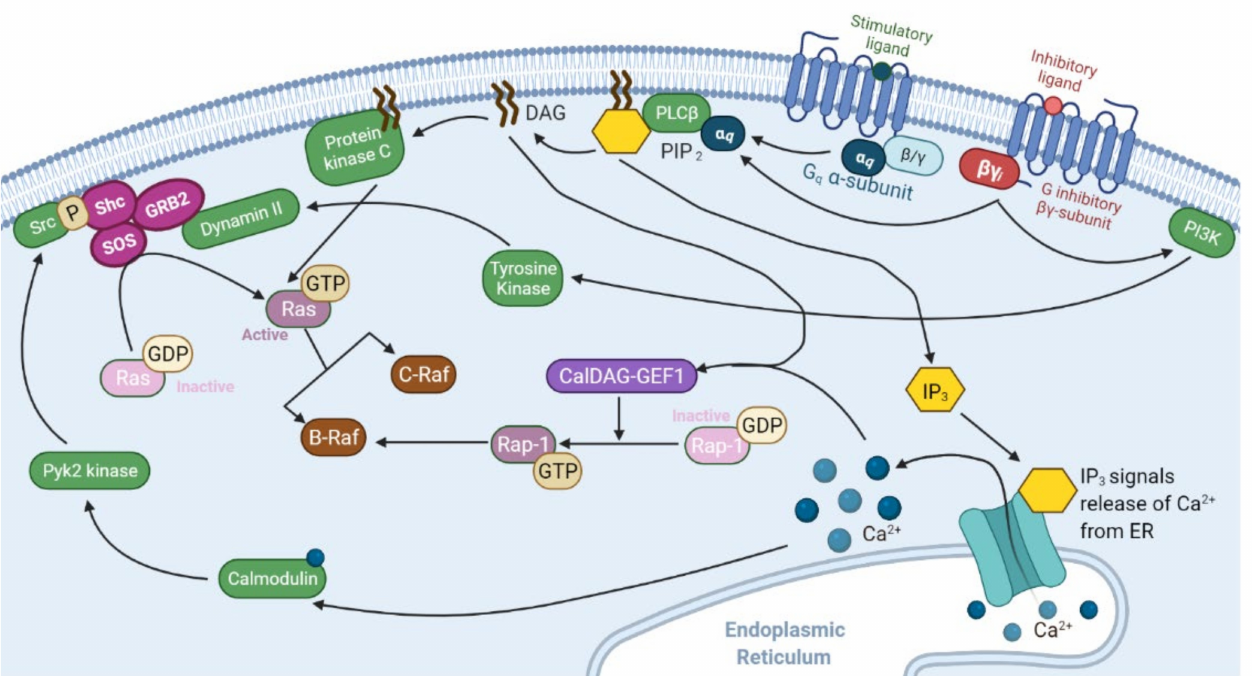
Figure 4. G protein-coupled receptor subunits G α q and G βγ i interaction with the Ras-Raf pathway. G-proteins are heterotrimeric guanine nucleotide binding proteins with α -, β -, and γ -subunits. When a ligand binds to the extracellular portion of the receptor, it confers a guanine nucleotide exchange factor confirmation that induces the α -subunit to exchange its bound GDP to GTP. This causes the α -subunit to disassociate from the receptor and βγ - subunit. Both the α and βγ subunits effect changes in the cell, before the α subunit hydrolyzes the GTP and returns the receptor complex to its inactive state [94,95,107,108]. Both α q and βγ i activate phospholipase C- β (PLC β ) to create the second messengers of diacylglycerol (DAG) and inositol-1,4,5-triphosphate (IP3) through the hydrolyzation of phosphatidylinositol 4,5-bisphosphate (PIP2) [109]. DAG activates PKC, which directly phosphorylates and activates Ras proteins [110,111]. IP3 stimulates the calmodulin pathway and Pyk2 kinase by way of inducing calcium release from the endoplasmic reticulum [112]. The resulting phosphorylation provides the base for Shc anchoring and recruitment of Ras’ guanine exchange factor complex [113]. Both DAG and IP3 play a role in allosterically controlling CalDAG-GEF1, a guanine exchange factor for Rap1 [94,114]. Once Rap1 has exchanged its bound GDP for GTP, it can activate BRaf in the place of Ras [115]. Furthermore, βγ i activates phosphoinositide 3-kinase (PI3K), which augments cell signaling from tyrosine kinase receptors to increase Dynamin II [116], an additional anchor for Shc and Ras’ GEF complex